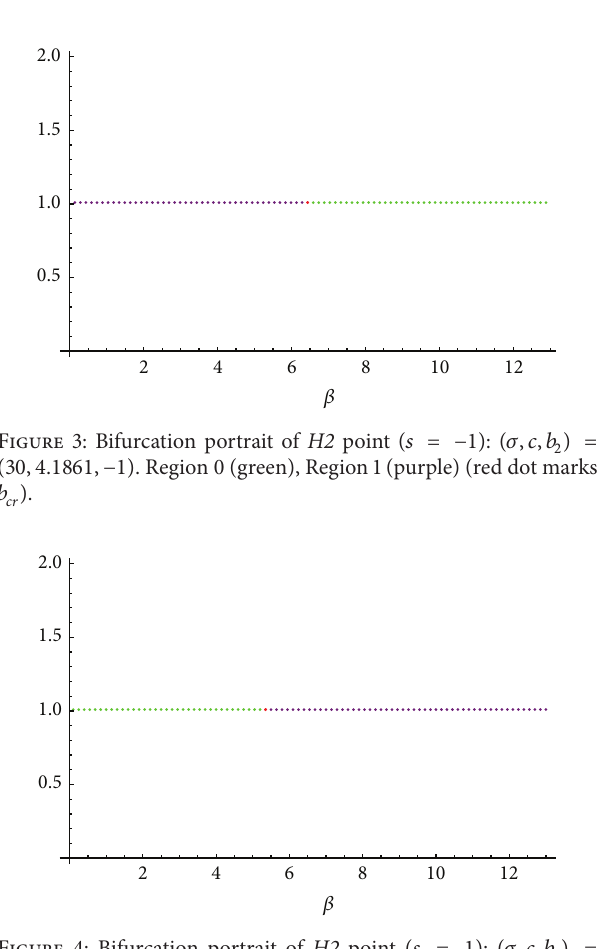
Figure 4: Bifurcation portrait of H2 point ( 𝑠 = 1 ): (𝜎,𝑐, 𝑏 2 ) = (2.2, 2.4871, −1) . Region 0 (green), Region 1 (purple) (red dot marks 𝑏 𝑐𝑟 ).